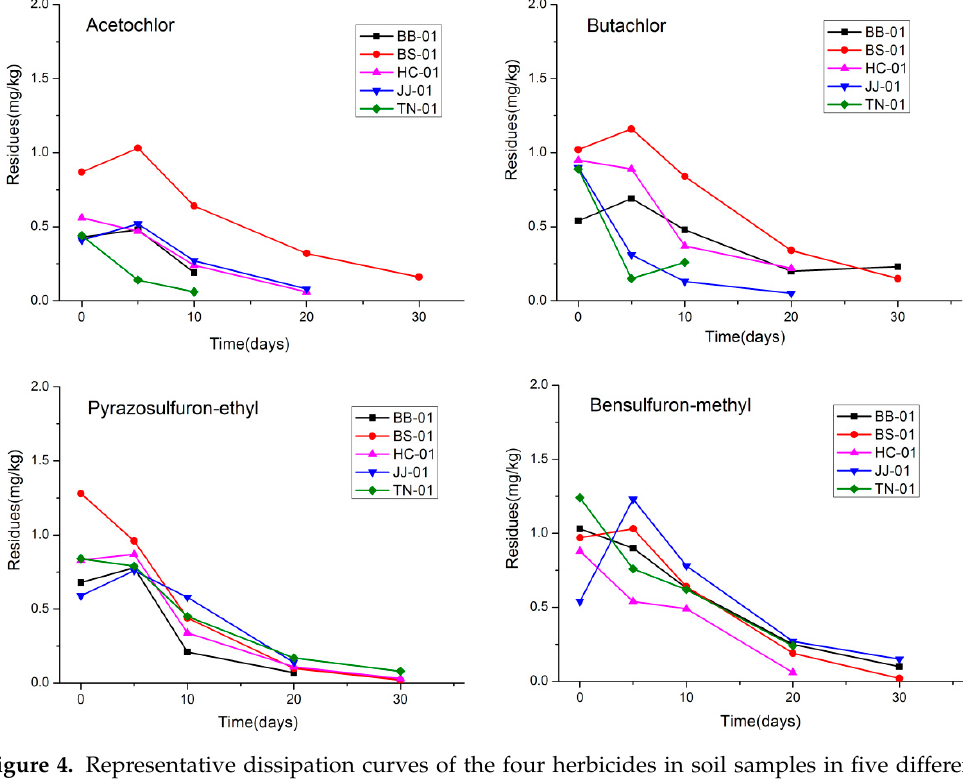
Int. J. Environ. Res. Public Health 2019 , 16 , x FOR PEER REVIEW 11 of 16